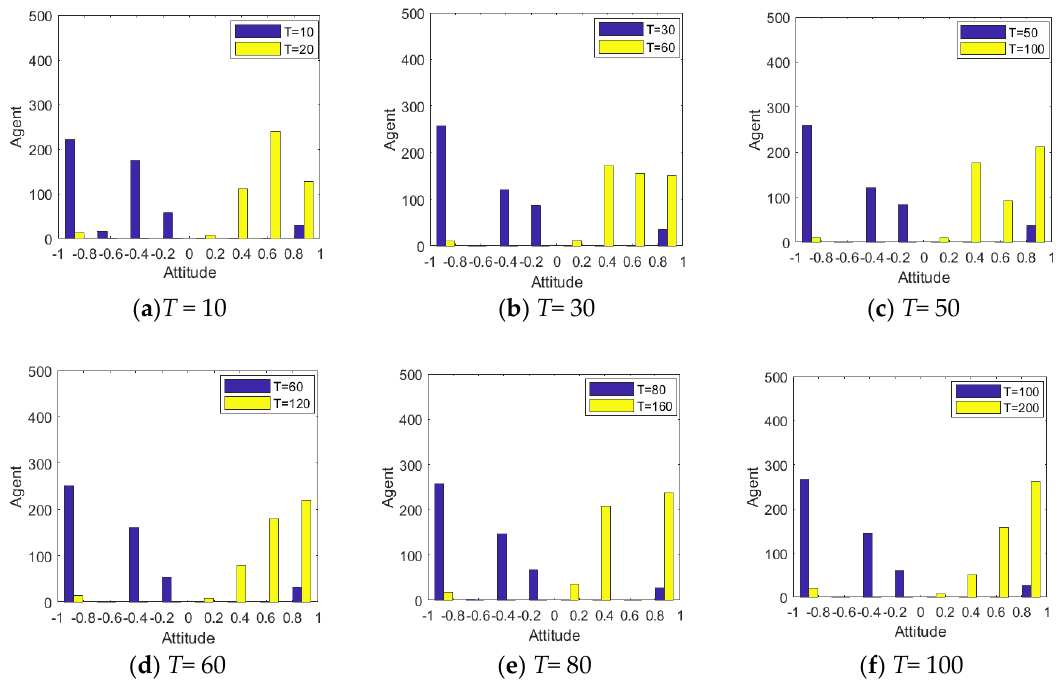
Figure 23. Distribution histogram of group attitude under different interaction times. ( a ) T = 10; ( b ) T = 30; ( c ) T = 50; ( d ) T = 60; ( e ) T = 80; ( f ) T = 100.